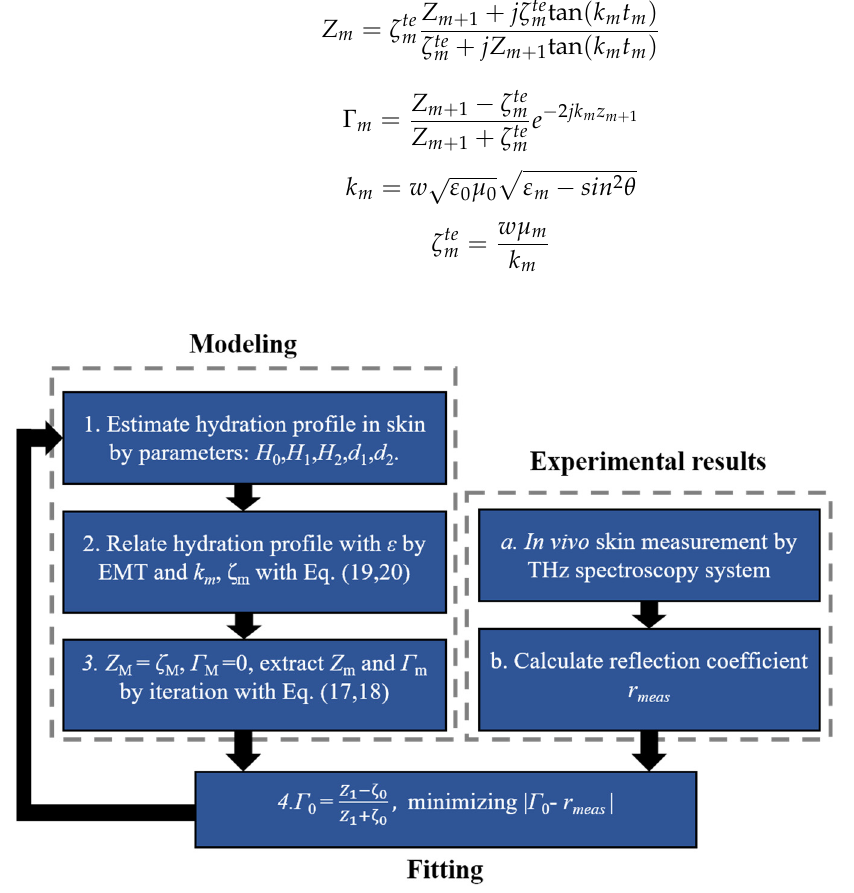
Figure 7. Flowchart for extracting skin hydration by Stratified media model.